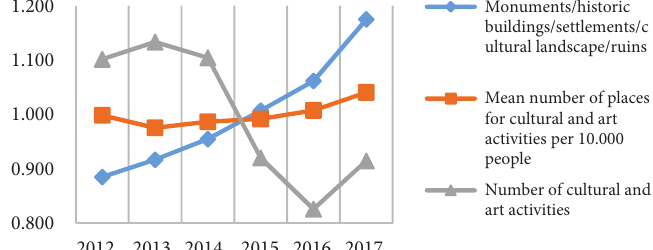
Figure 4. Cultural and societal